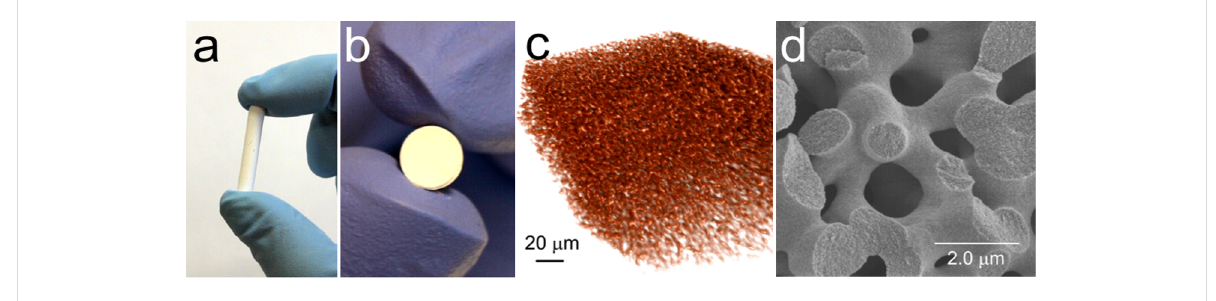
Figure 13: Images of the bimodal TiO 2 monolith with well-defined macroporosity: (a, b) optical; (c) X-ray tomography; (d) scanning electron microscopy. Reprinted with permission from [163], © 2012 American Chemical Society.